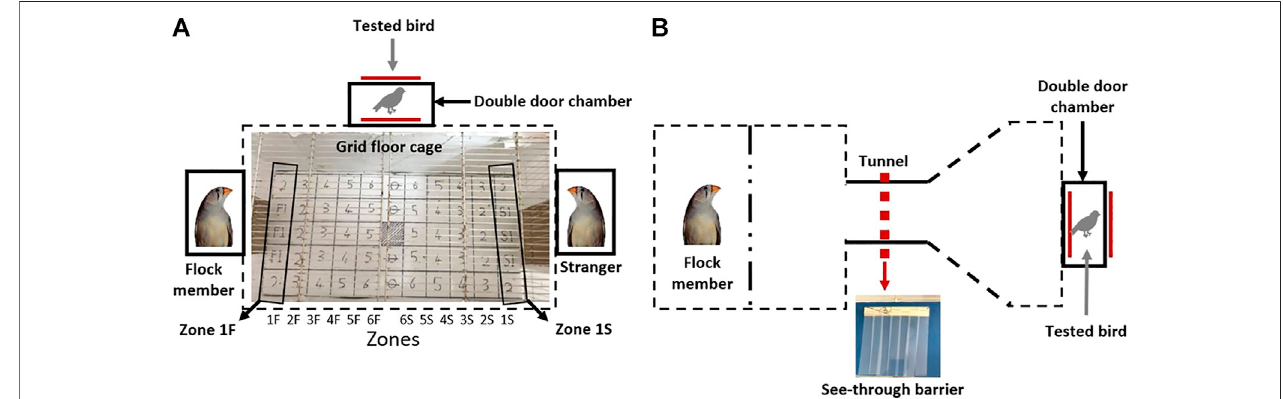
FIGURE2| Aschematicdepictionofthecagesdesignedforthe (A) socialpreferenceand (B) motivationtests.Thegridwithnumberedsquaresthatwasprintedon the main chamber fl oor in the cage of the social preference test is shown in (A) . Each vertical line of squares was de fi ned as a “ zone ” . Zones 1F and 1S are indicated as examples. See text for